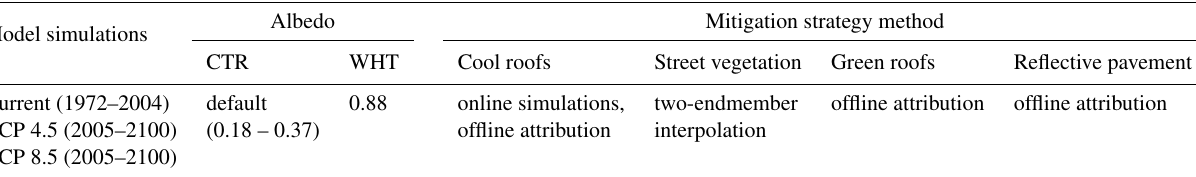
Table 1. The simulations run and the methods used to assess the temperature mitigation strategies. The online simulation method calculated the mitigation potential of cool roofs as the difference between the WHT and CTR simulations (WHT – CTR). The offline attribution and two-endmember interpolation methods used diagnostic data from the CTR